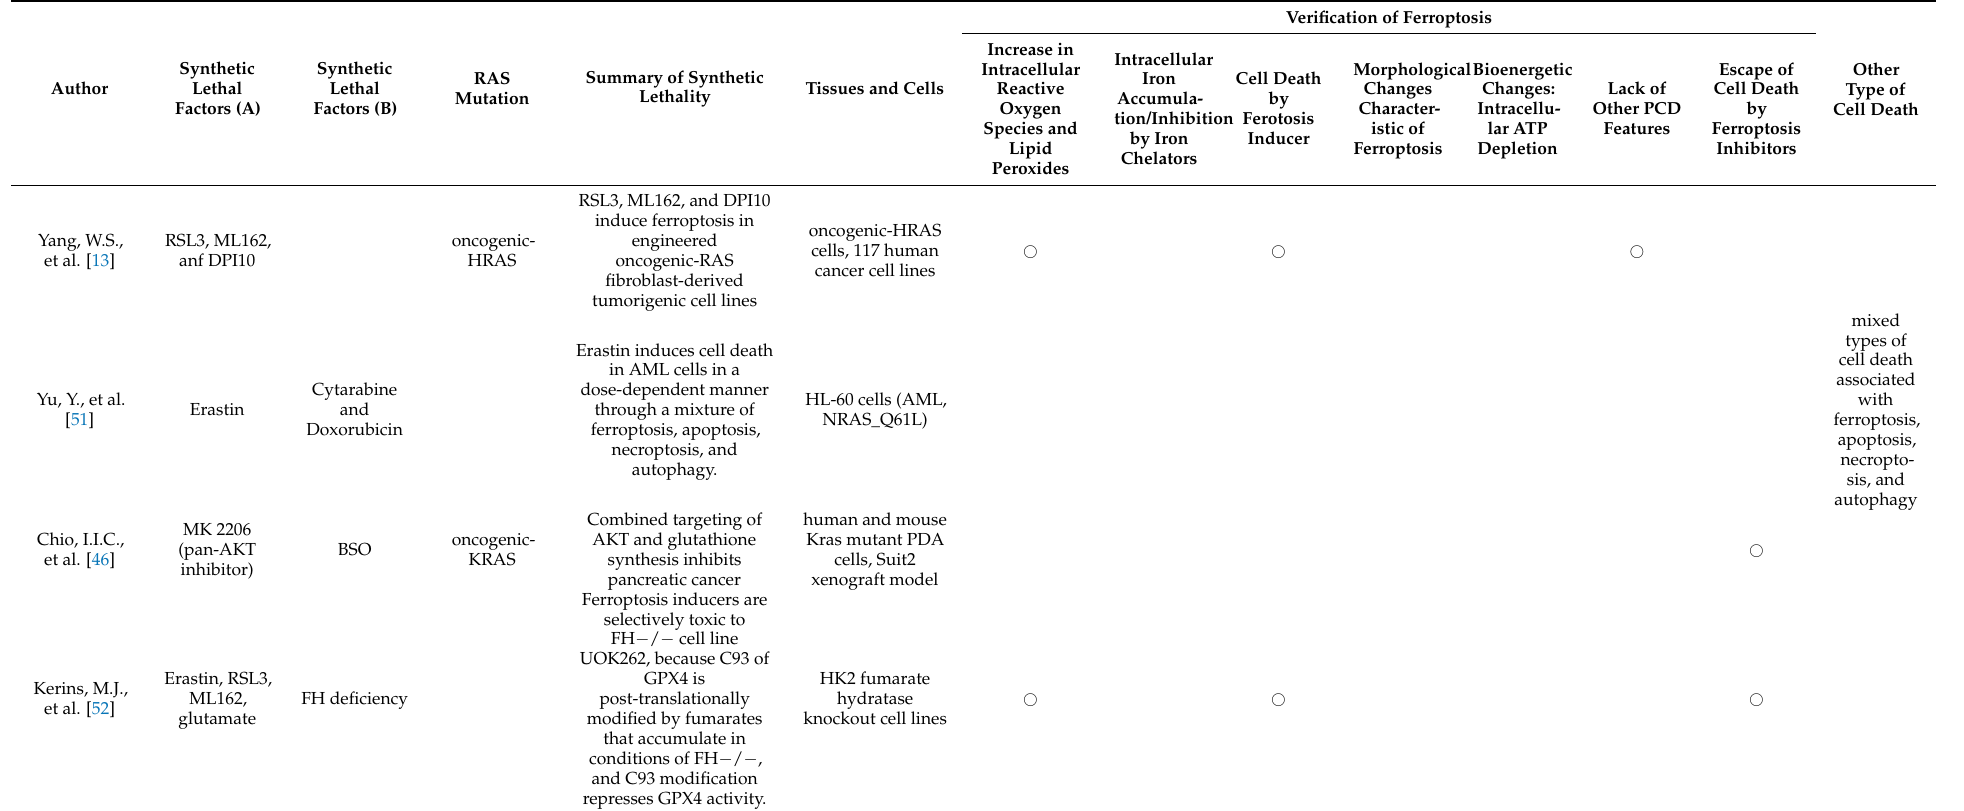
Table 3. Synthetic Lethality and Regulators of